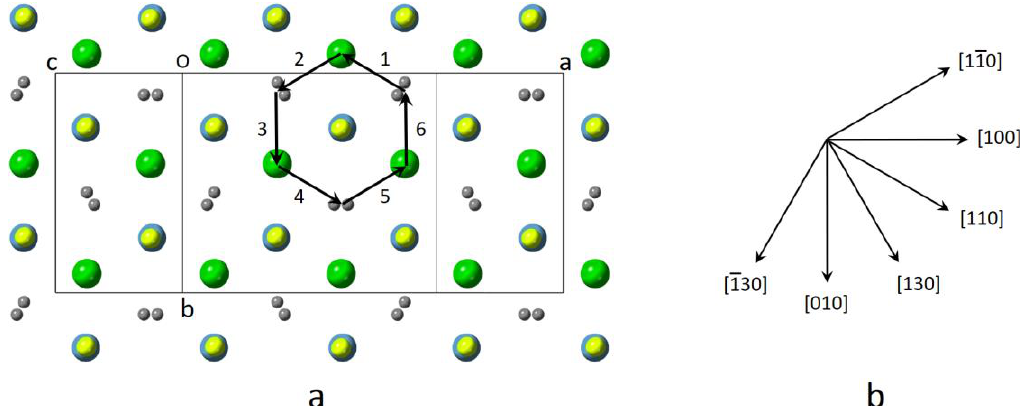
Figure 12. ( a ) Projection on (001) of a fgdg -layer of synchysite-(Ce) showing the allowed shifts related by 60 ◦ rotations (1 to 6) of the carbonate-layer (arrows). Filled circles indicate atom positions (green = F; blue = Ca; yellow = Ce; grey = C) and solid lines the monoclinic unit cell. ( b ) Drawing of the main crystallographic directions along which fluorcarbonates are commonly observed by HRTEM. Note that, depending on the observation direction, on the image plane (perpendicular to it) a given shift may have a component equal to b / 3 (~2.37 Å); b / 3 · cos(30 ◦ ) (~2.05 Å, or a / 6); or b / 3 · cos(60 ◦ ) (~1.18 Å or b / 6); or 0 (summary in Table 4). Table 4. Shift Magnitude on the (001) Plane of the Carbonate-Layer in (Ca,REE)-Fluorcarbonates as Function of Both the Operating Stacking Vector (First Row) and of The Observation Direction (Left Column). The Minus Sign Indicates that the Shift Has a Component Along the Negative Semi-Axis of the Monoclinic Unit Cell.